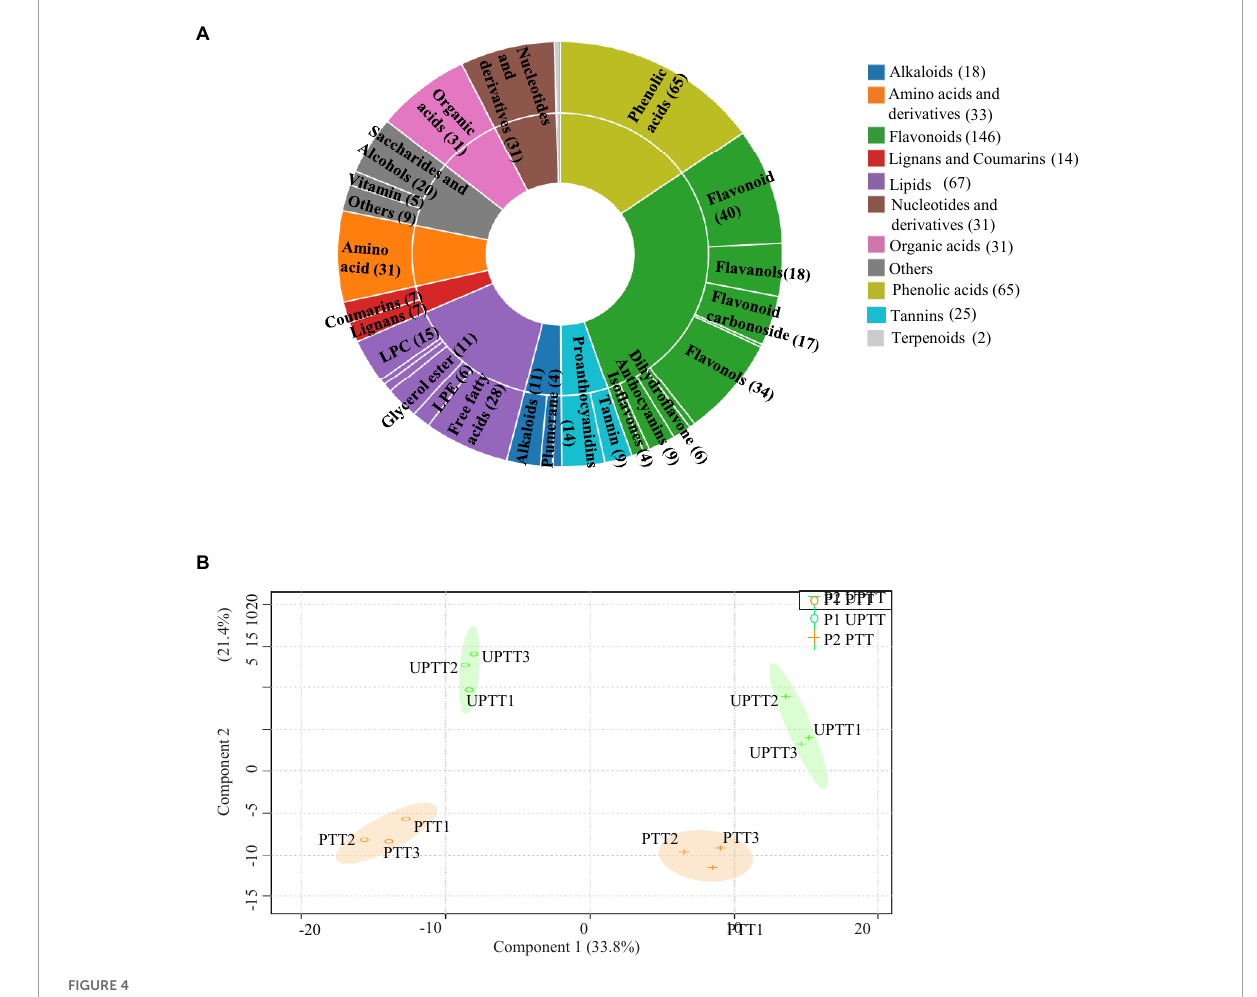
FIGURE4 The metabonomics analysis. Classification of identified metabolites (A) ; OPL-based peak areas of identified metabolites (B) .